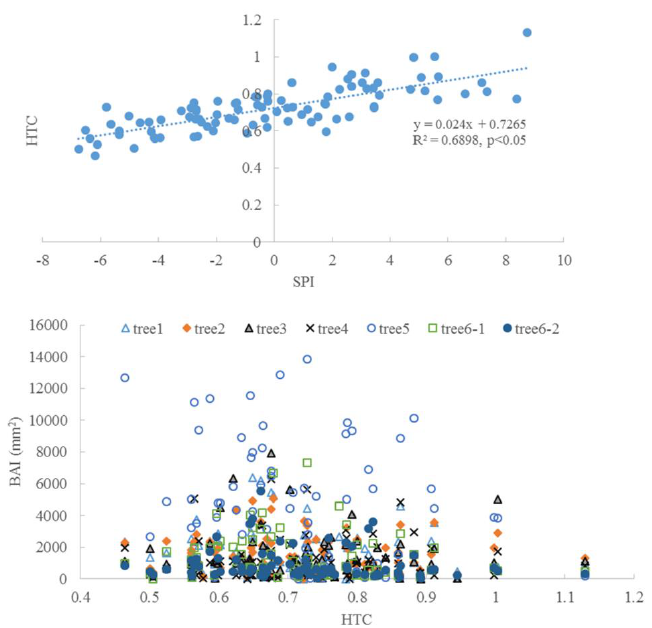
Figure 10. The correlation between SPI and HTC and the change of BAI along with HTC.